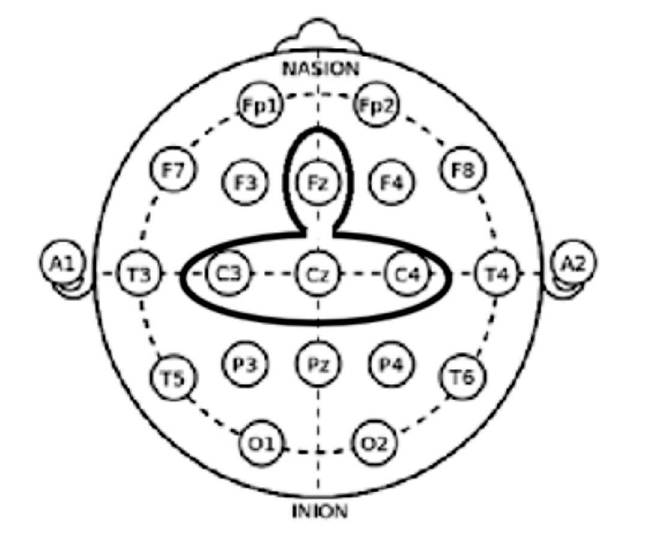
Figure 2. Measurement points (motor cortex area) (Kawala-Janik et al.,